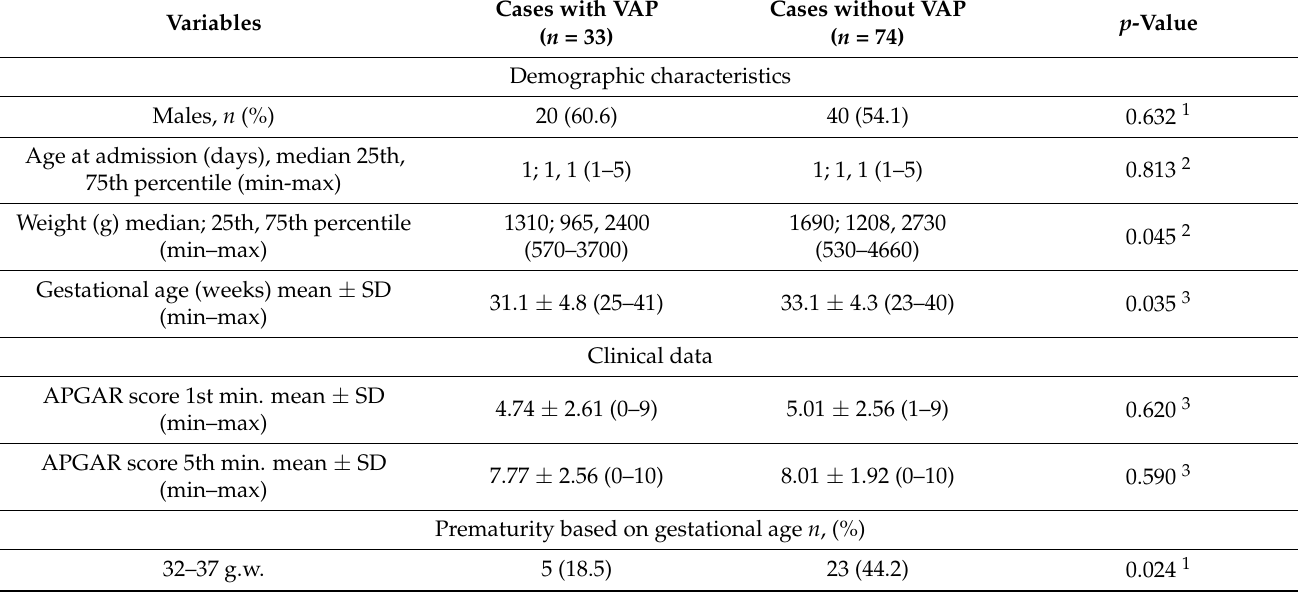
Table 1. Comparison of patient characteristics in the study by